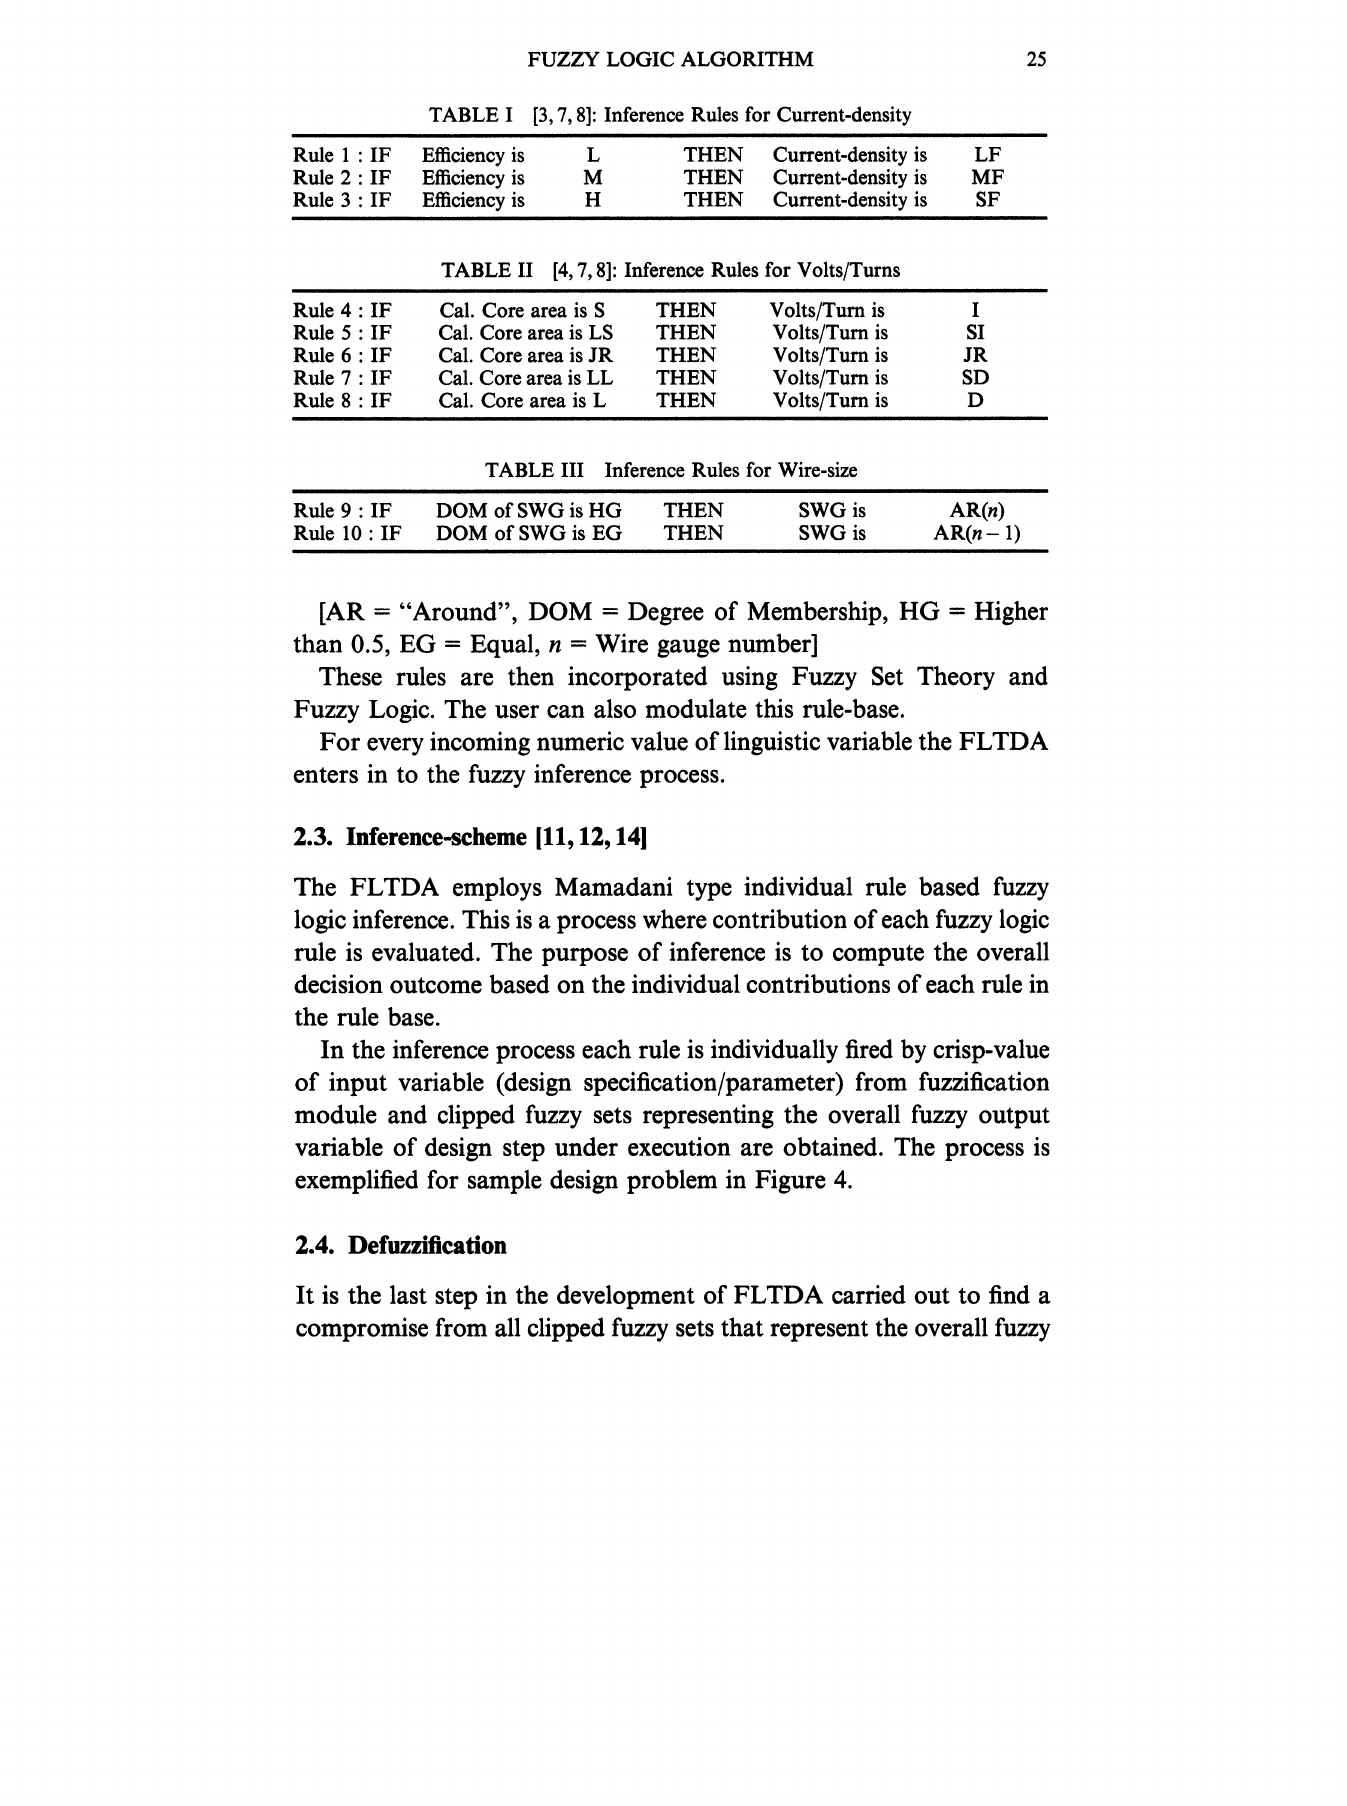
TABLE III Inference Rules for